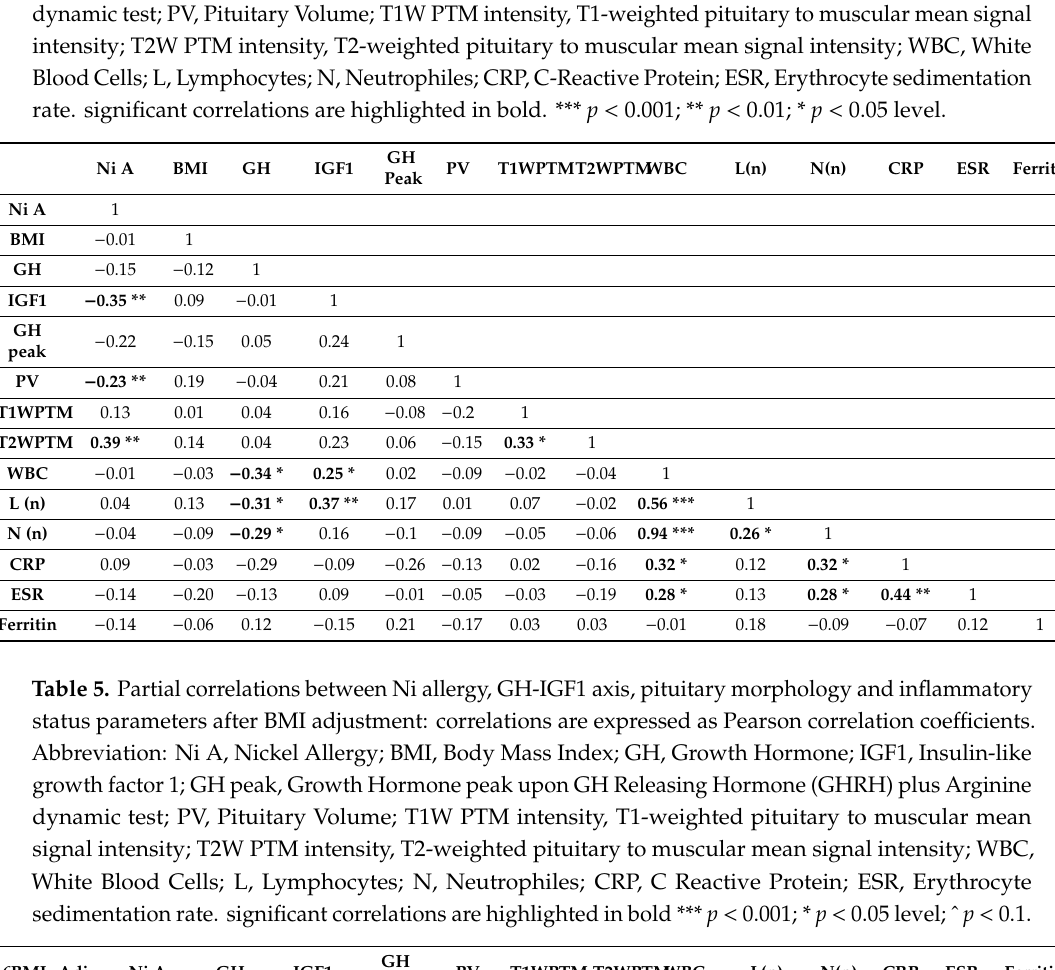
Table 4. Bivariate correlations between Ni allergy, BMI, GH-IGF1 axis, pituitary morphology and inflammatory status parameters: correlations are expressed as Pearson correlation coe ffi cients.